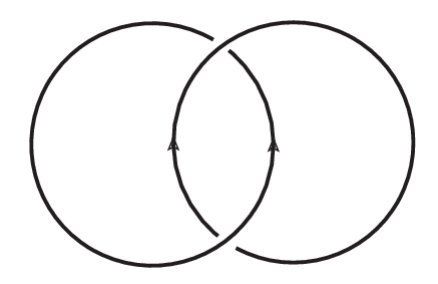
Figure 4. Hopf link L 2 a 1.